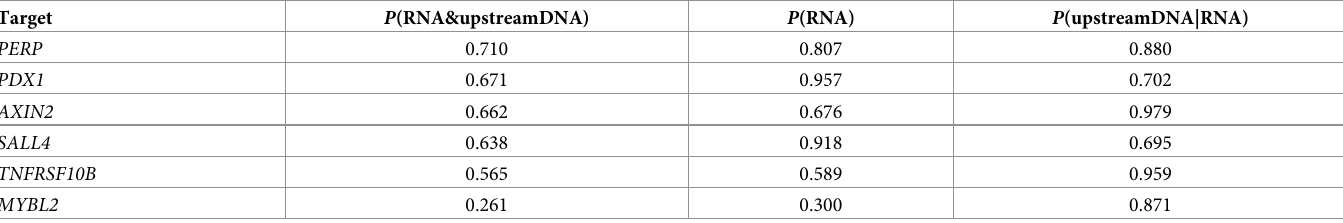
Table 4. Colon core target genes. There are six “core” target genes which appear in every minimal target covering of the colon samples. P (RNA) is the fraction of samples for which the indicated target gene is RNA-aberrant; P (RNA&upstreamDNA) is the fraction of samples for which the indicated target gene is RNA-aberrant and there exists an DNA-aberrant gene among its sources. P (upstreamDNA|RNA) is the fraction of the samples with the indicated gene RNA-aberrant for which at least one of its sources is